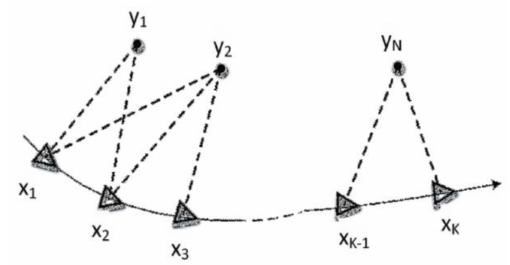
Figure 1. Schematic diagram of carrier